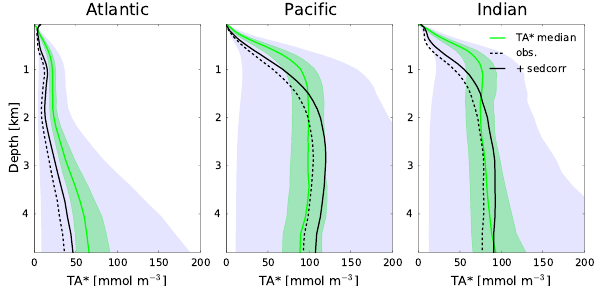
Figure 4. Model ensemble vs. observation-based basin-mean TA ∗ profiles. The grey shading shows the unconstrained prior and the green shading shows the constrained (68% confidence interval) dis- tribution of the model ensemble. Lines represent the median of the constrained ensemble (green), observation-based TA ∗ (black dashes), and observation-based TA ∗ corrected for a sediment burial flux of 0.12Gt Cyr − 1 (black solid). The corresponding Southern Ocean sector is included in the